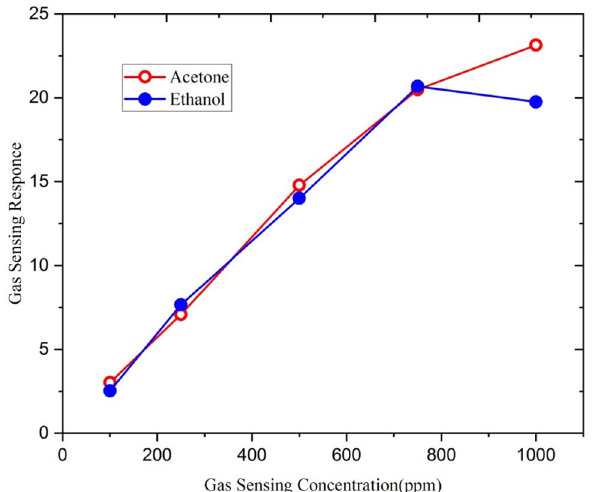
Figure 21. Sensing response of 3at % Ga doped ZnO thin film (Si 6+ ion irradiated with 5 × 10 13 ion fluence) for ethanol and acetone (250 ppm concentration) at 500 °C operating temperature.